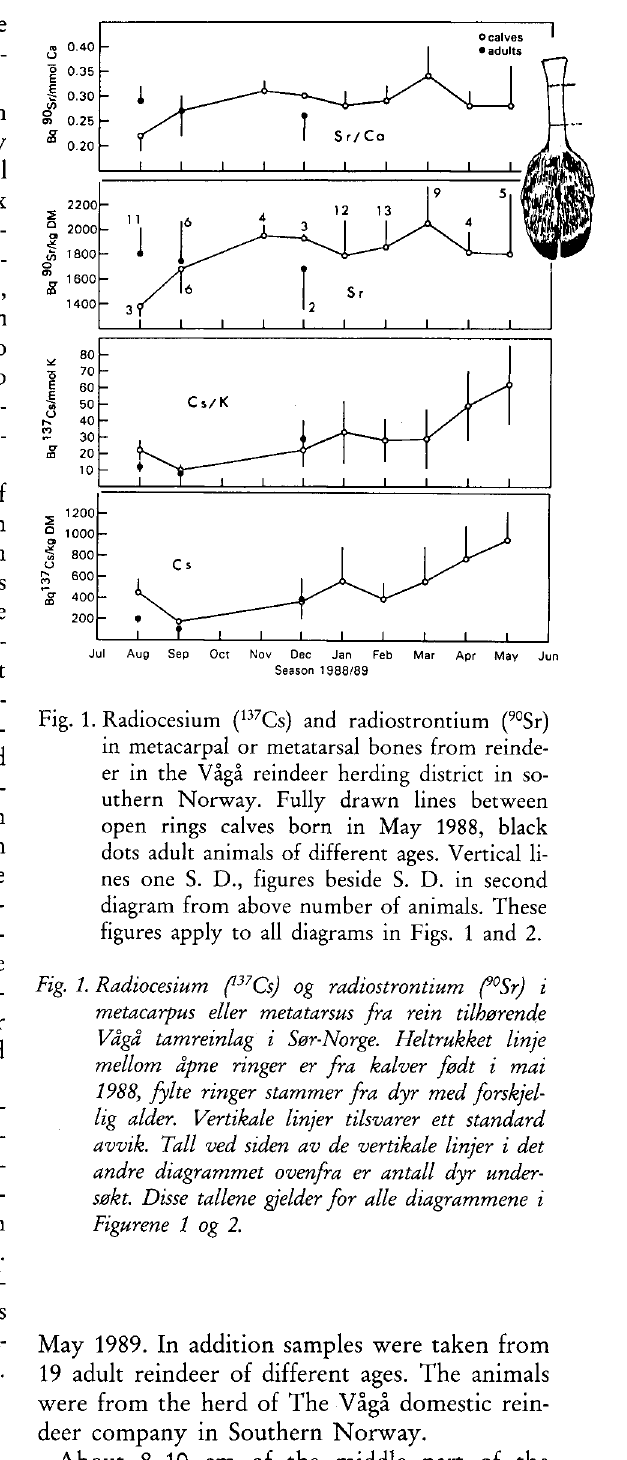
May 1989. In addition samples were taken from 19 adult reindeer of different ages. The animals were from the herd of The Vågå domestic